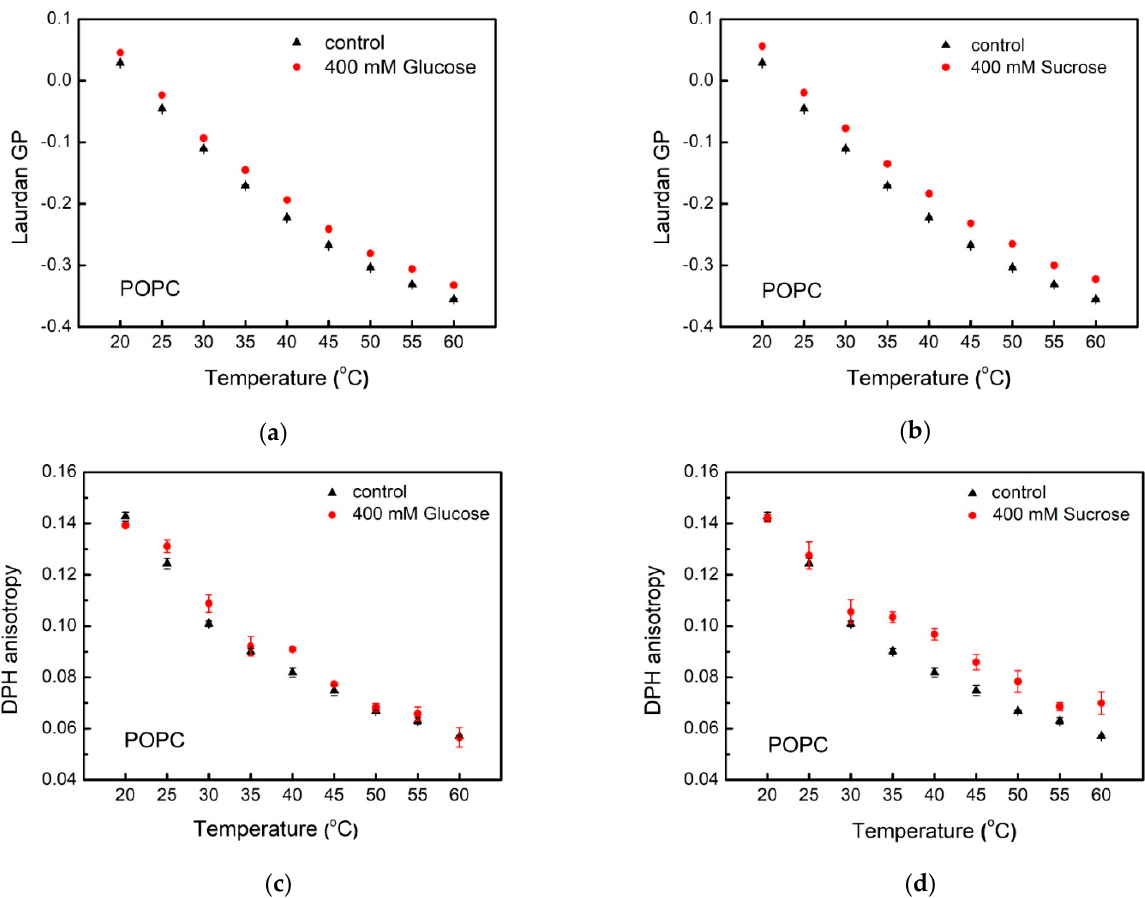
Figure 6. Fluorescence spectroscopy data for POPC membranes: Laurdan 𝐺𝑃 as a function of temperature in: ( a ) glucose and ( b ) sucrose solutions; DPH anisotropy vs. temperature in ( c ) glucose and ( d ) sucrose solutions.